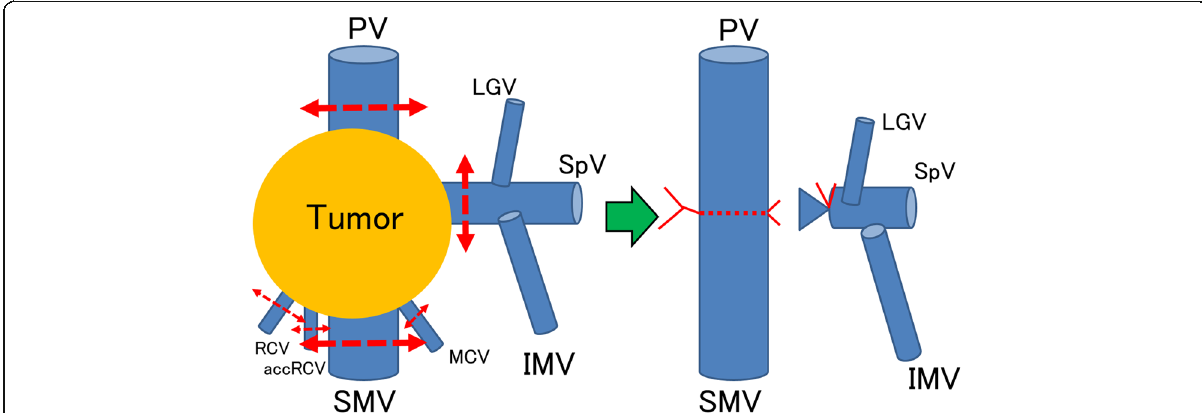
Fig. 1 Schema of the operation. The schema of the operation is depicted. SSPPD with PVR was performed. PV had 4 cm of its length resected, and end-to-end anastomosis was performed without reconstructing the SpV. RCV, accRCV, and MCV which received reflux directly from the PV- SMV were all resected due to tumor invasion. PV, portal vein; SMV, superior mesenteric vein; RCV, right colic vein; accRCV, accessary right colic vein; MCV, middle colic vein; LGV, left gastric vein; SpV, splenic vein; IMV, inferior mesenteric